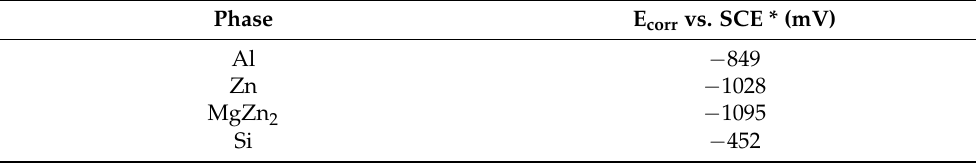
Table 6. Main phases detected in the ZAMS coating and corrosion potential in 0.6 M NaCl [46].